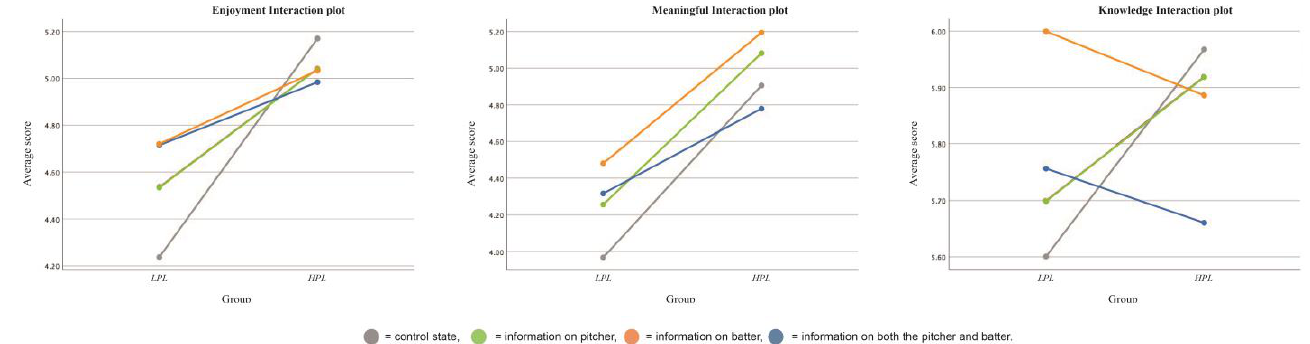
Figure 3. Evaluation of media entertainment experience’s Interaction plot.